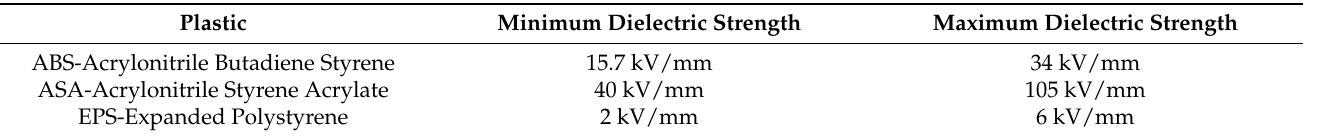
Table 1. Dielectric properties of